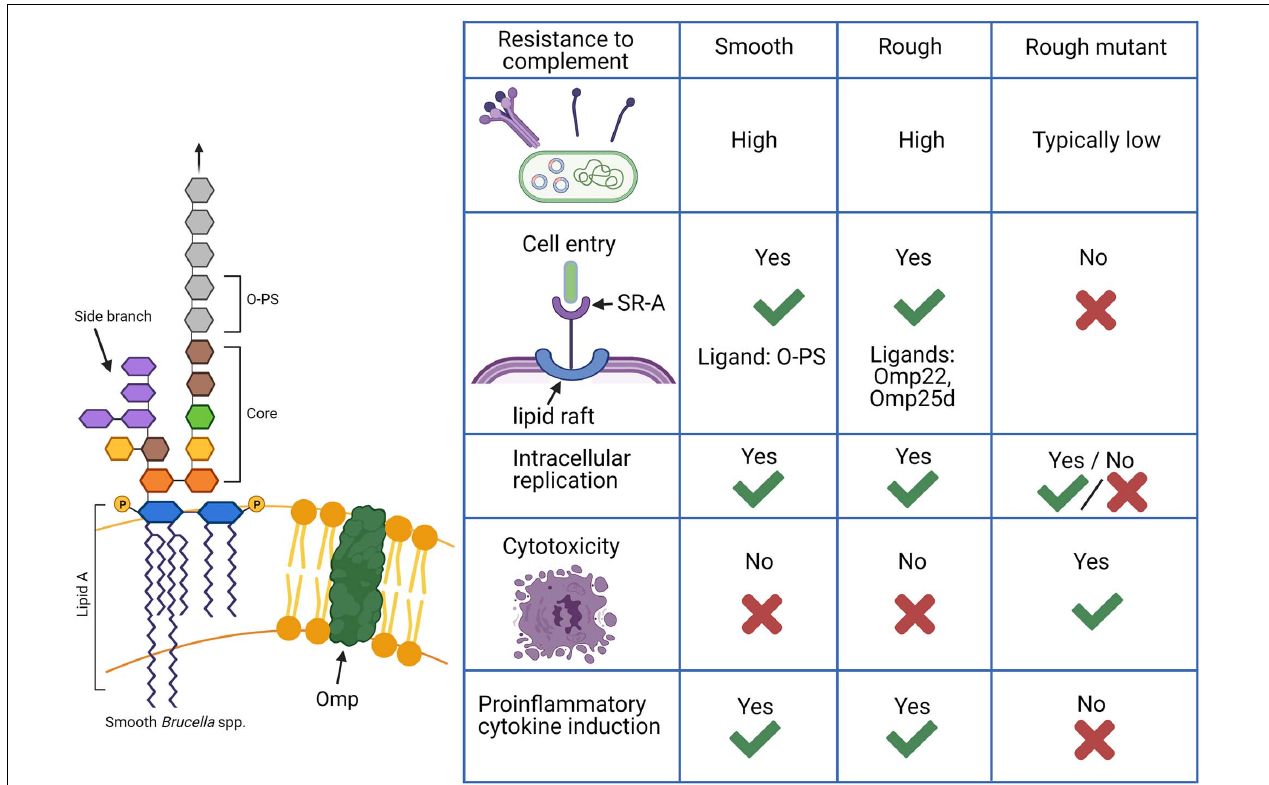
FIGURE 2 | Functions of lipopolysaccharide (LPS) in Brucella spp. in comparison between smooth, rough, and rough mutant strains. Smooth Brucella spp. are known to be far more resistant to destruction by complement while rough mutants derived from these strains, in which the O-polysaccharide (O-PS) is not produced, are generally susceptible. Natural rough Brucella spp., such as B. canis , exhibit complement resistance as high or higher than their smooth counterparts despite a lack of O-PS with additional components such as the core oligosaccharide side branch and outer membrane proteins (Omps) making contributions. An additional difference is the ability of smooth and natural rough Brucella spp. to enter cells using lipid rafts and replicate intracellularly while rough mutants are typically unable to do this. Smooth Brucella spp. use O-PS as a ligand for the scavenger receptor, SR-A on host cells while natural rough Brucella spp. are thought to use outer membrane proteins for this interaction. Finally, rough mutants are known to cause cytotoxicity following cell infection and induce significant proinflammatory cytokine production while natural smooth and rough Brucella spp. do not. Such changes indicate that natural rough Brucella spp. are able to compensate for the loss of O-PS during infection. Created with